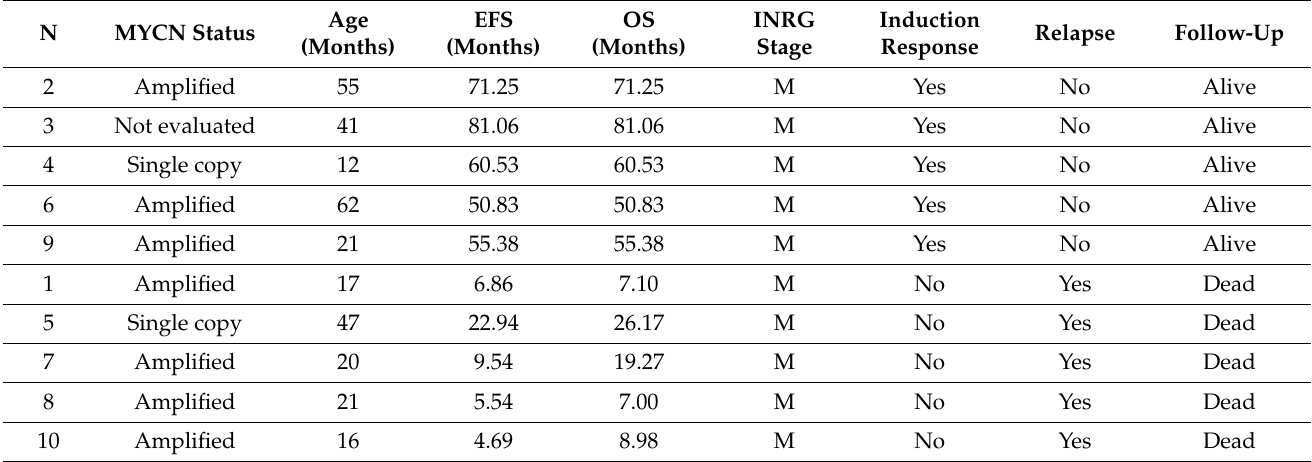
Table 3. NB characteristics and patient clinical outcomes.